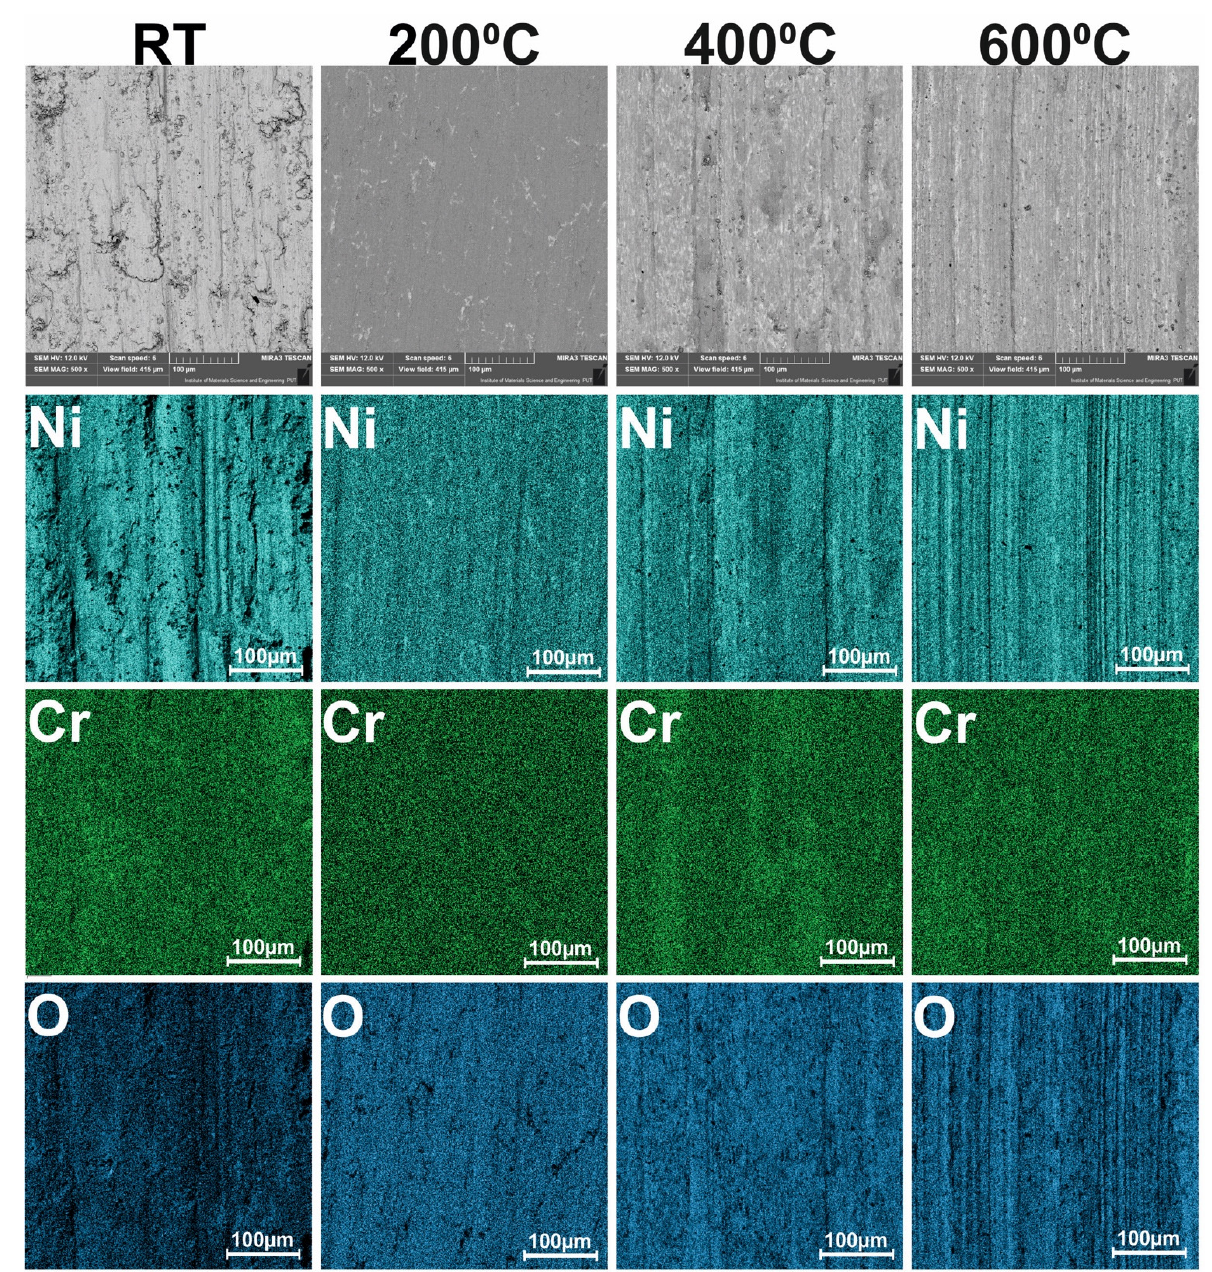
Figure 16. Results of EDS analysis of the worn Ni-50%NiCr(80/20) samples tested at different temperatures.